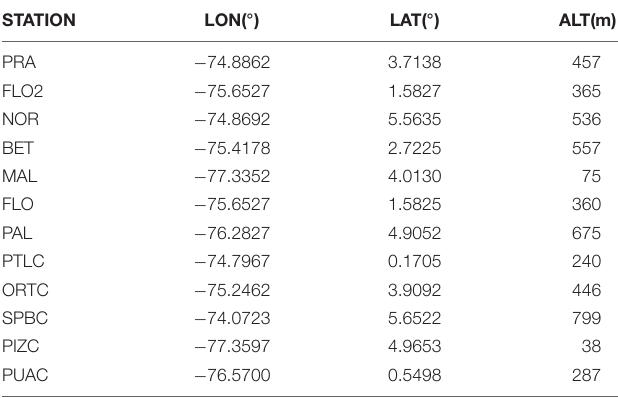
TABLE 1 | Seismological stations used for estimating Q − 1 c